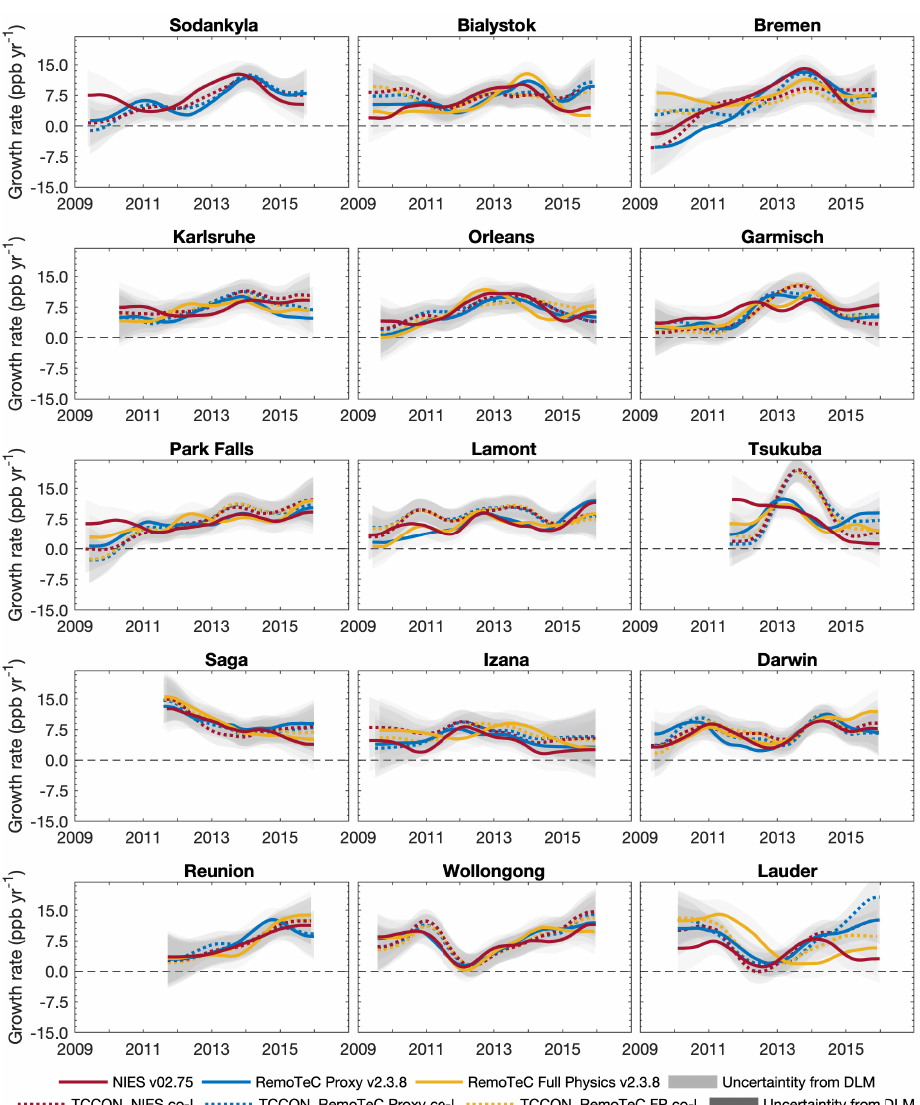
Figure 6. Variability of the trend for three GOSAT XCH 4 retrievals (solid lines) and co-located TCCON retrievals (dashed lines) evaluated at 11 sites in the Northern Hemisphere and four sites in the Southern Hemisphere. The sites are arranged by their latitude from the northernmost (Sodankylä) to the southernmost (Lauder). Grey areas describe the 1 σ , i.e., 68.3%, uncertainty ranges given by the DLM